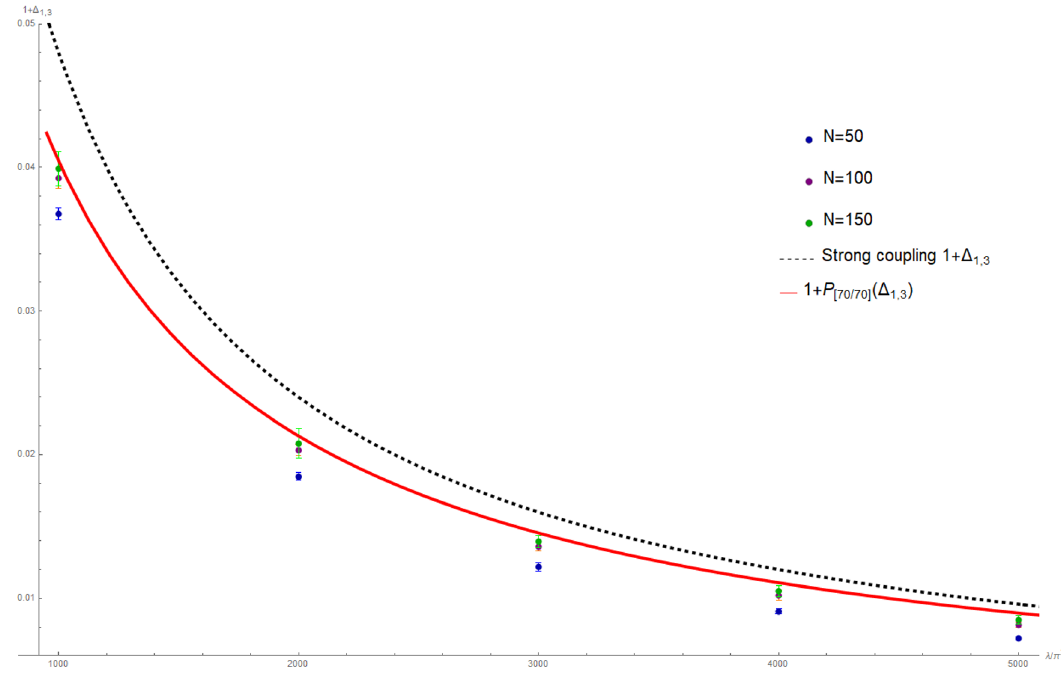
Figure 5 : Padé curve (red solid curve), MC data (colored points) and the strong-coupling prediction (black dashed curve) for the function 1 + ∆ ( λ ) in the range 1000 π 2 ≤ λ ≤ 1 , 3 5000 π 2 of the M = 4 quiver theory. The Padé curve is obtained from the diagonal Padé approximant of order 70 of the perturbative series, while the strong-coupling prediction is 48 π 2 /λ . One clearly sees that, as N increases, the MC points systematically tend towards the Padé